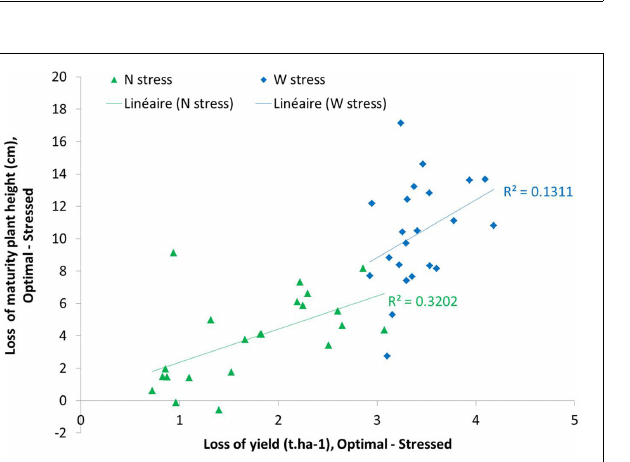
FIGURE 14 | Correlation between yield (t.ha − 1 ) and plant height during grain filling.